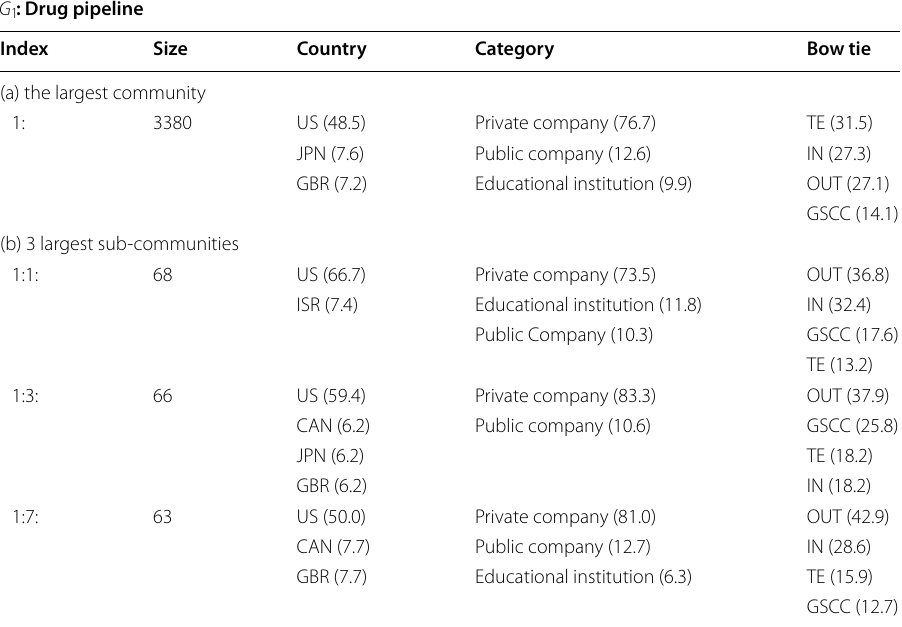
The figures in parentheses indicate the fraction of attribution, and we have only listed the attributions having a share of more than